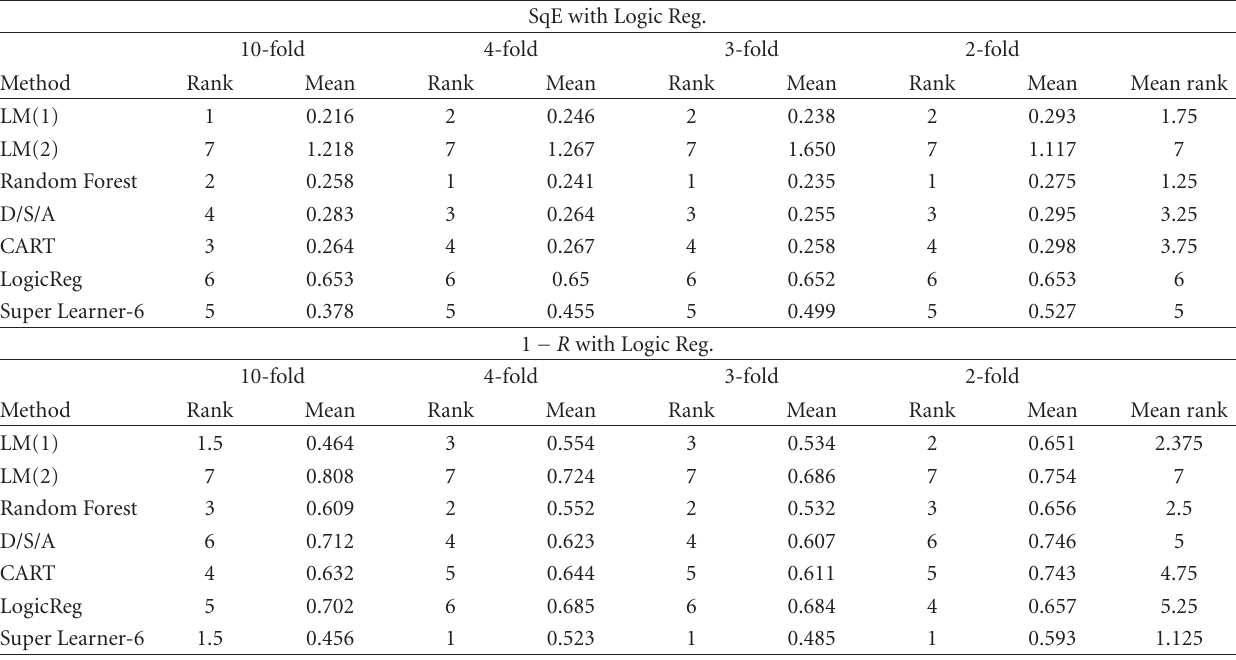
Table 2: Squared error, R detailed values and corresponding rank on Jaguar trial data for 10-fold, 4-fold, 3-fold, and 2-fold. SqE with Logic Reg.